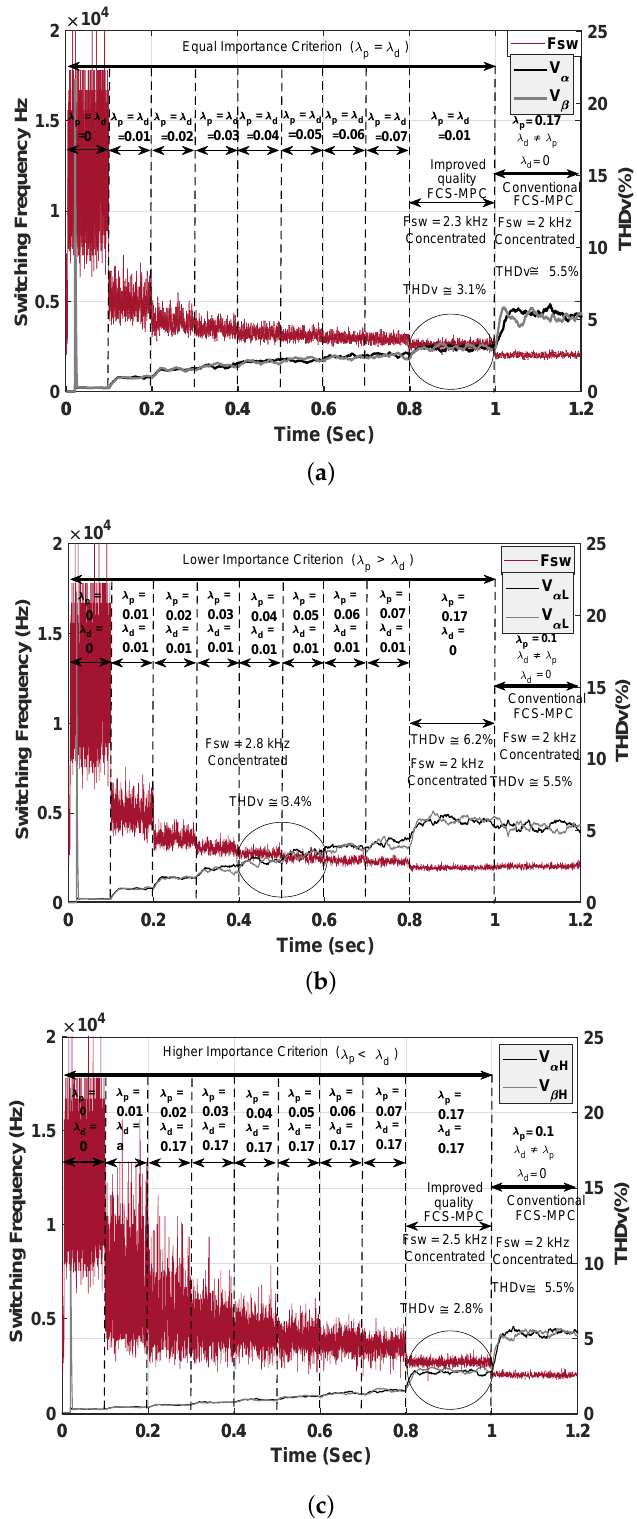
Figure 22. Measured switching frequencies and THDv for the three criteria at 1 kW ( a ) the drift of the weights, where the derivative weighting factor λ d is equal to the periodic weighting factor λ p ; ( b ) the drift of the weights, where the derivative weighting factor λ d is lower than the periodic weighting factor λ p ; and ( c ) the drift of the weights, where the derivative weighting factor λ d is higher than the periodic weighting factor λ p . ( a ) Equal importance case; ( b ) Lower importance case; ( c ) Higher importance